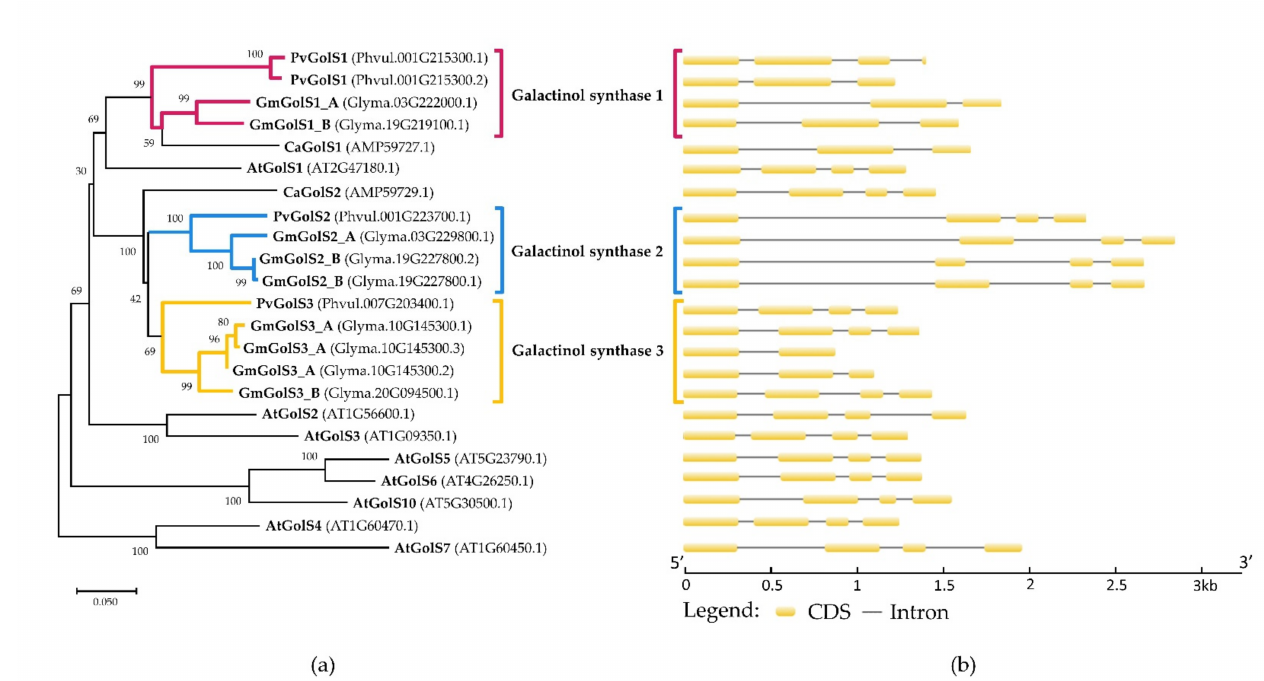
Figure 1. Analysis of the phylogenetic relationships and gene structures of galactinol synthase (GolS). ( a ) Evolutionary relationship of GolS enzymes of G. max , P. vulgaris and other well-characterized taxa ( A. thaliana and C. arietinum) . The GolS enzymes of P. vulgaris and G. max are subdivided into three different classes based on their clustering (GolS1, GolS2 and GolS3. The phylogenetic tree was made in MEGA X (v10.2.4) using the neighbor-joining algorithm combined with a bootstrap test of 1000 replicates (next to the branches, the percentage of replicate trees in which the associated taxa clustered together is shown) [46–48]. The Poisson correction method was used to compute the evolutionary distances with the number of amino acid substitutions per site as a unit [49]. The phylogenetic tree was drawn to scale using the calculated evolutionary distances as branch lengths. This analysis involved 23 amino acid sequences. For each sequence pair, all ambiguous positions were removed using the pairwise deletion option and the final dataset consisted of 355 positions. The multiple sequence alignment was created using the MUSCLE algorithm; ( b ) structures of genes encoding the GolS enzymes were visualized using GSDS software